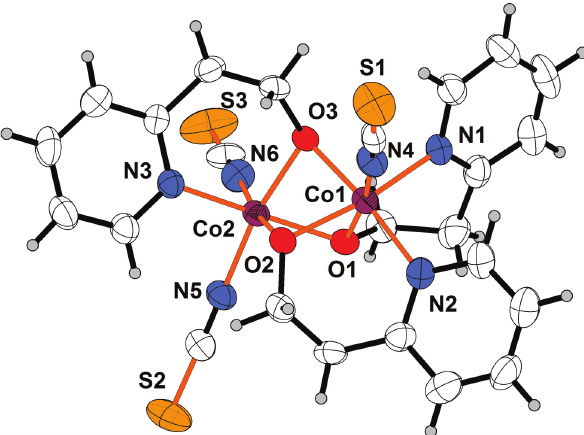
Table 2: Fractional atomic coordinates and isotropic or equivalent isotropic displacement parameters (Å 2